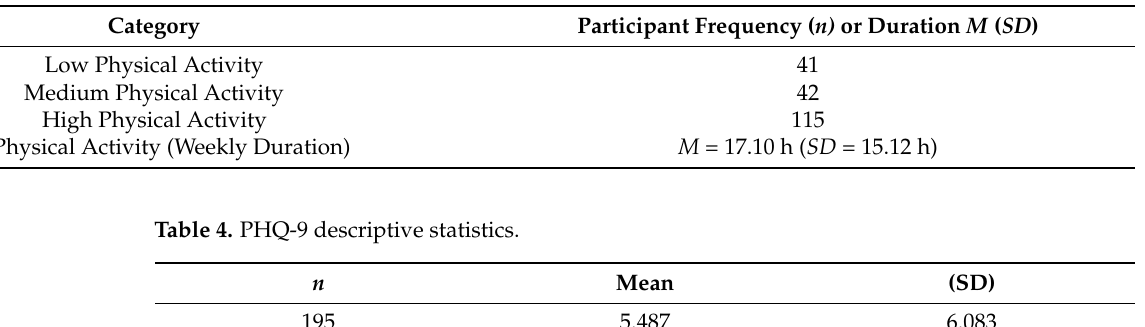
Table 3. IPAQ-SF descriptive statistics.